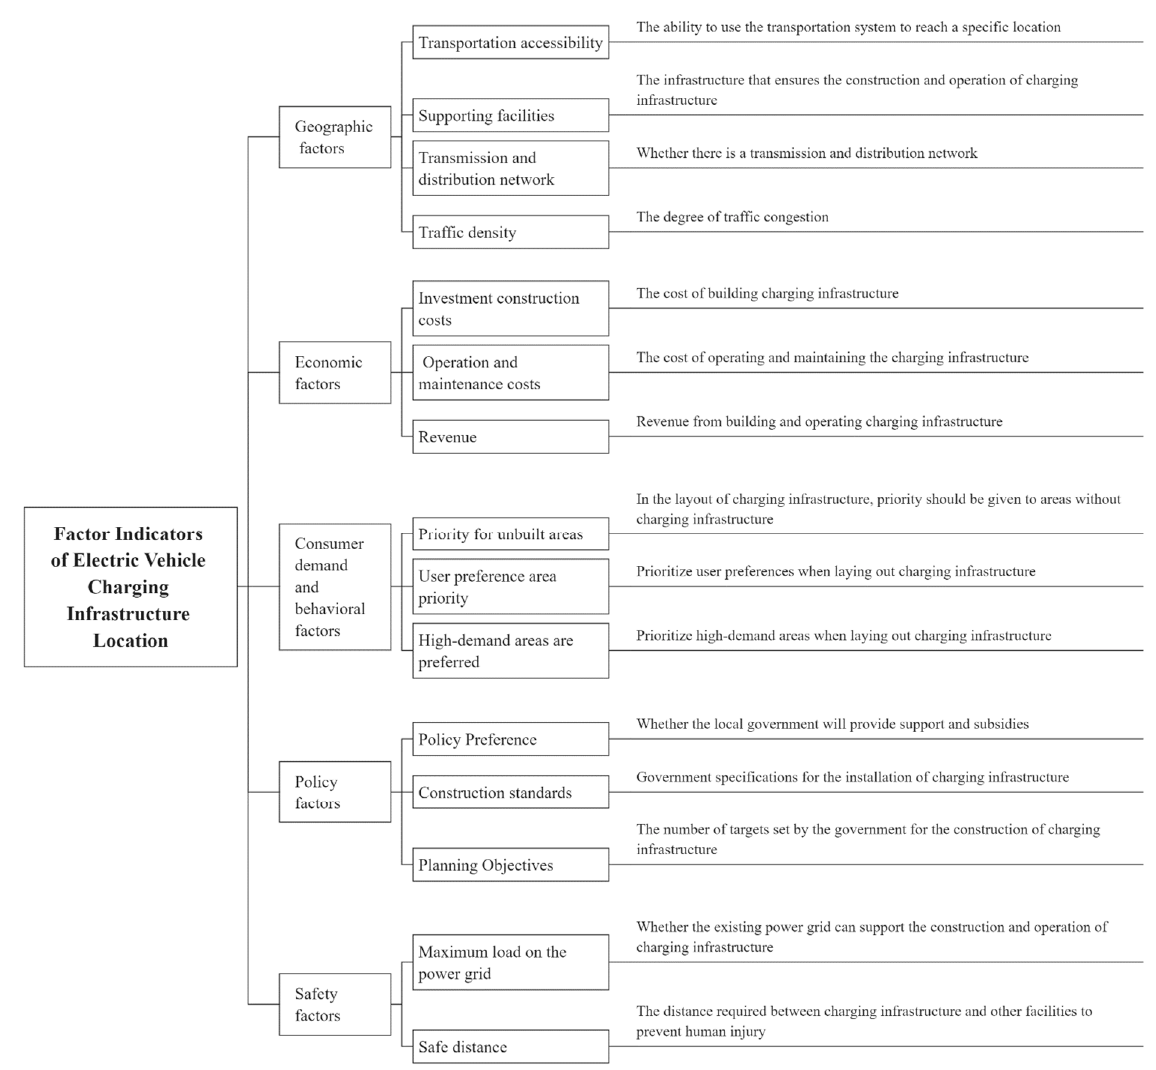
Figure 6. Factor indicators of electric vehicle charging infrastructure location.